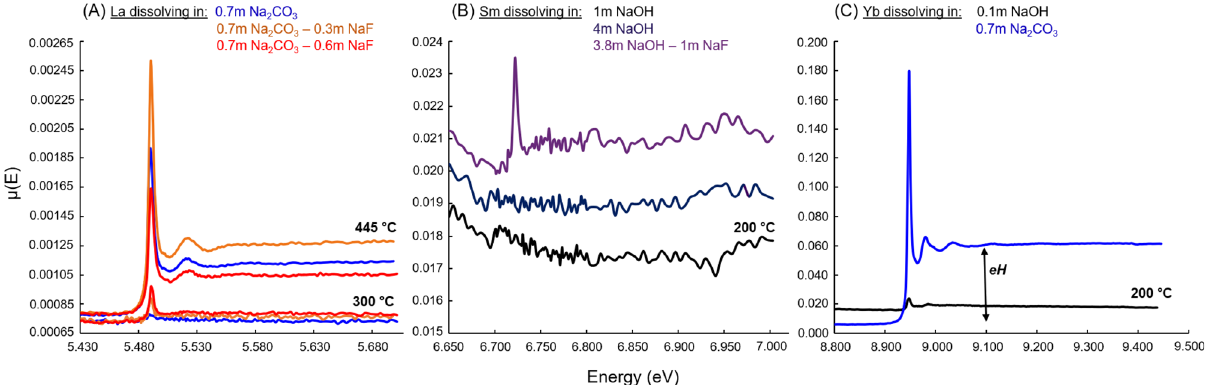
Fig. 1 Examples of fl uorescence spectra used to evaluate La (A), Sm (B), and Yb (C) hydrothermal concentrations. Enhanced solubility of REE in the hydrothermal fl uids is evidenced by an increase of the fl uorescence absorption edge jump, which is shown as eH on ( C ). La data were collected at 40 MPa, other REE data were collected at